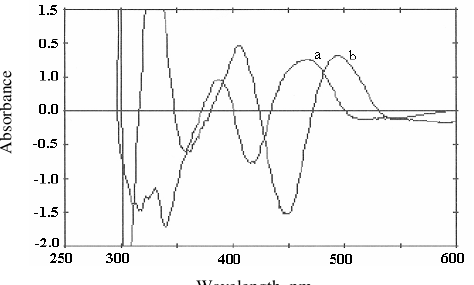
Figure 2. Third-order derivative spectra of (a) Cu-NDTT complex and (b) Ni-NDDT